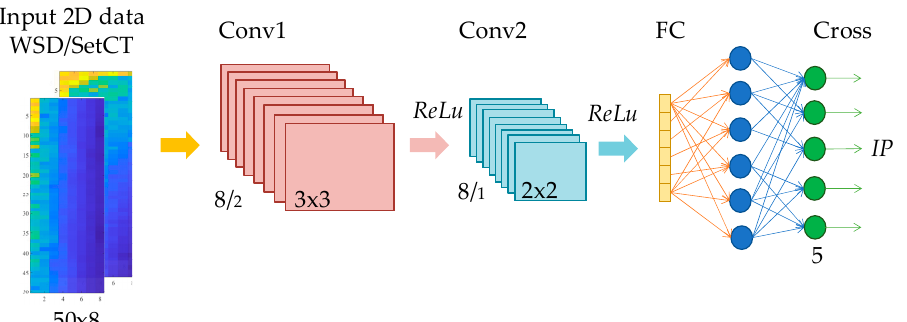
Figure 11. CNN structure for low-resolution 2D data.